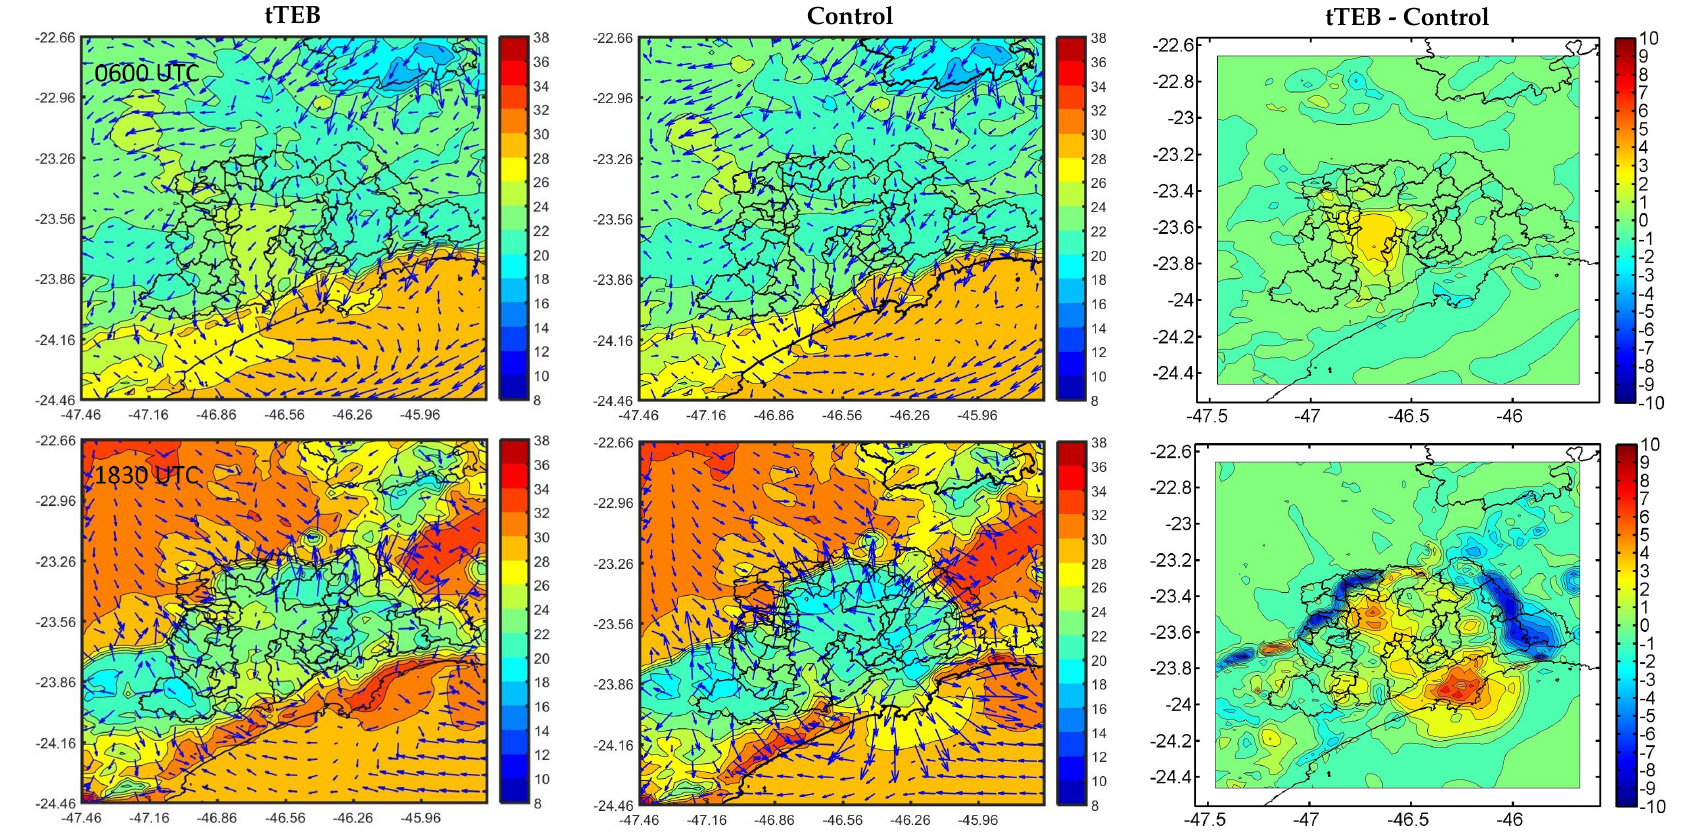
Figure 11. Vertical cross section of mean air temperature ( ◦ C) between 46.90 ◦ W to 46.42 ◦ W at 06 UTC (03 LT) (first row), 1830 UTC (1530 LT) (second row) along the latitude. The figure shows the results of the tTEB experiment (first column), the control experiment (second column) and the differences between both experiments (third column). Triangles indicate the extension of urban canopy of the